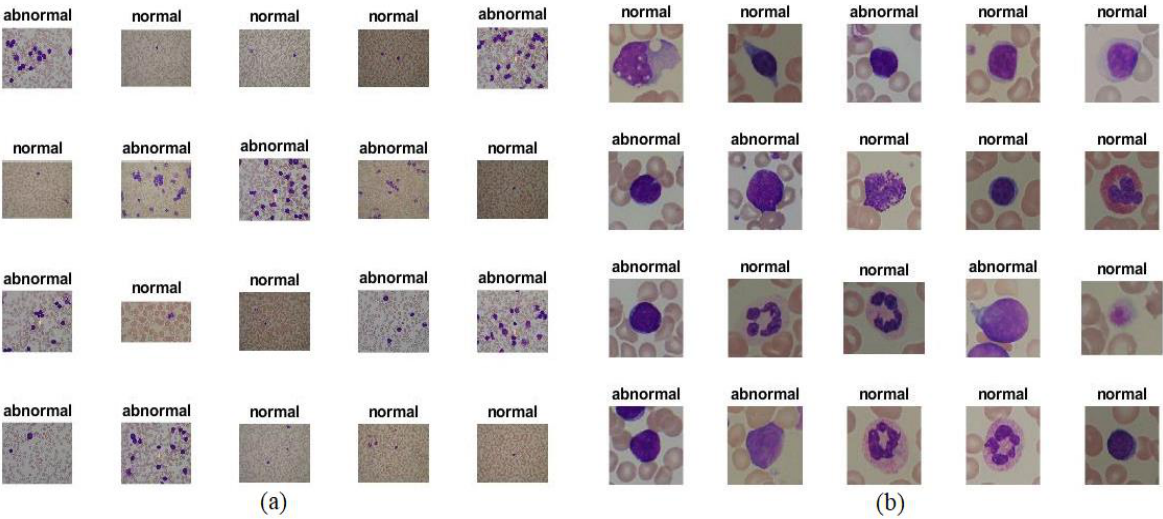
Figure 2. Samples from the ( a ) ALL-IDB1 and ( b ) ALL-IDB2 datasets.